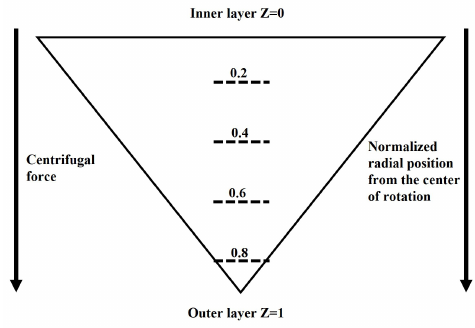
Figure 3. Schematics of the